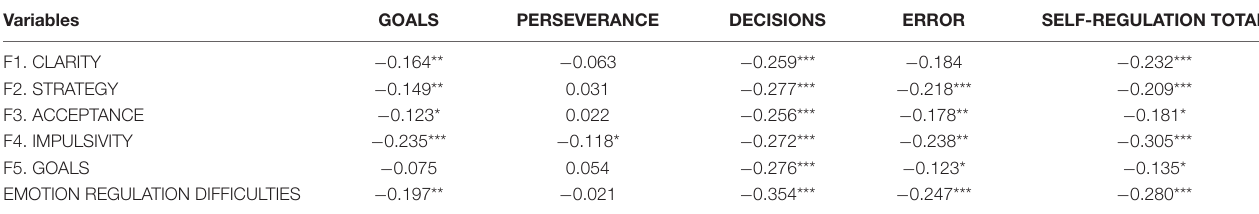
TABLE 3 | Bivariate correlations between self-regulation (SR) and emotion regulation difficulties (ERD). Variables GOALS PERSEVERANCE DECISIONS ERROR SELF-REGULATION